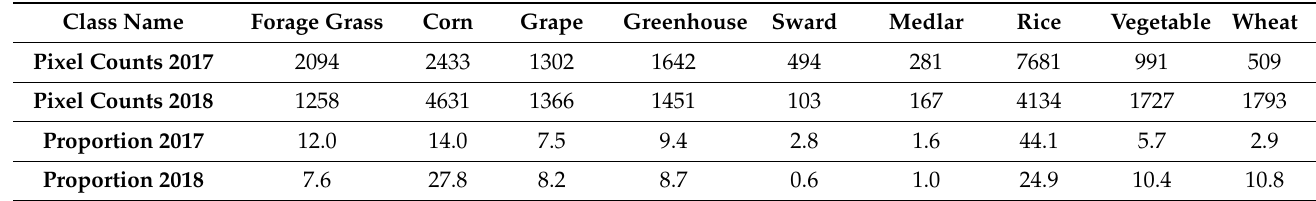
Table 3. The number of training samples at 30 m and the proportion for each crop